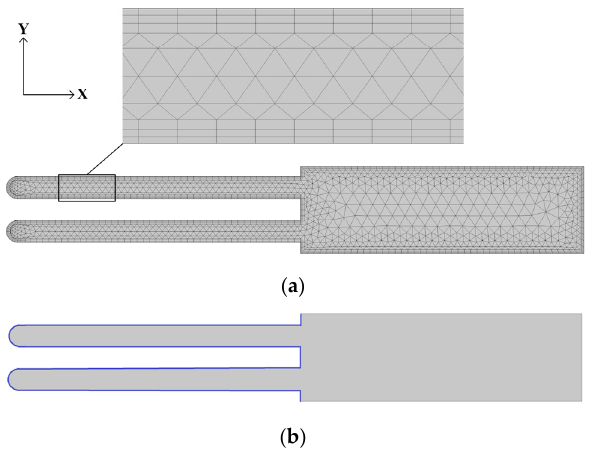
Figure 1. Simulation model. ( a ) Geometry and computational mesh for nanopores; ( b ) boundary conditions.